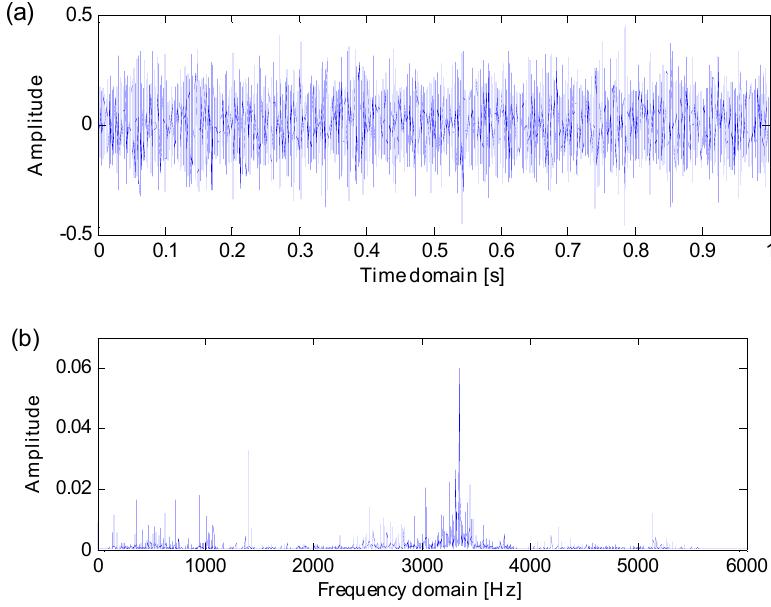
Figure 15. ( a ) Data X224_DE in time domain; ( b ) the spectrum of X224_DE in frequency domain.